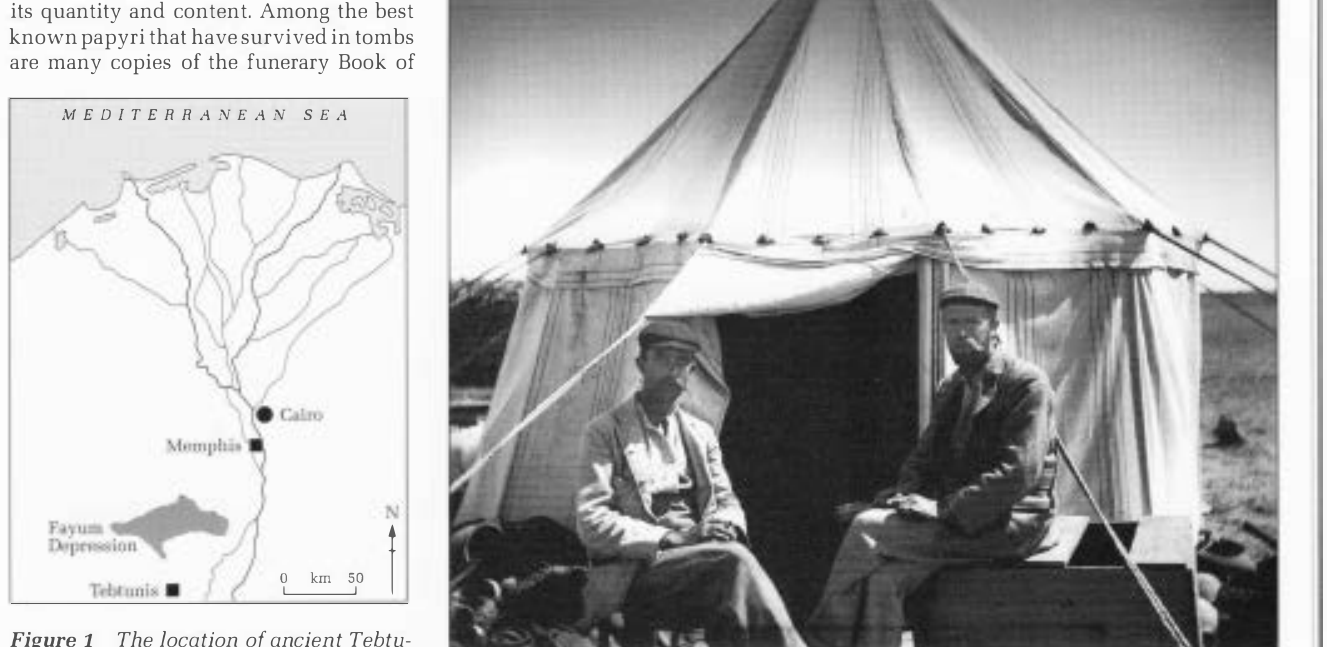
Figure 2 Bernard Grenfell (left) and Arthur Hunt outside their tent during the 1899- 1 900 excavations at Tebtunis.